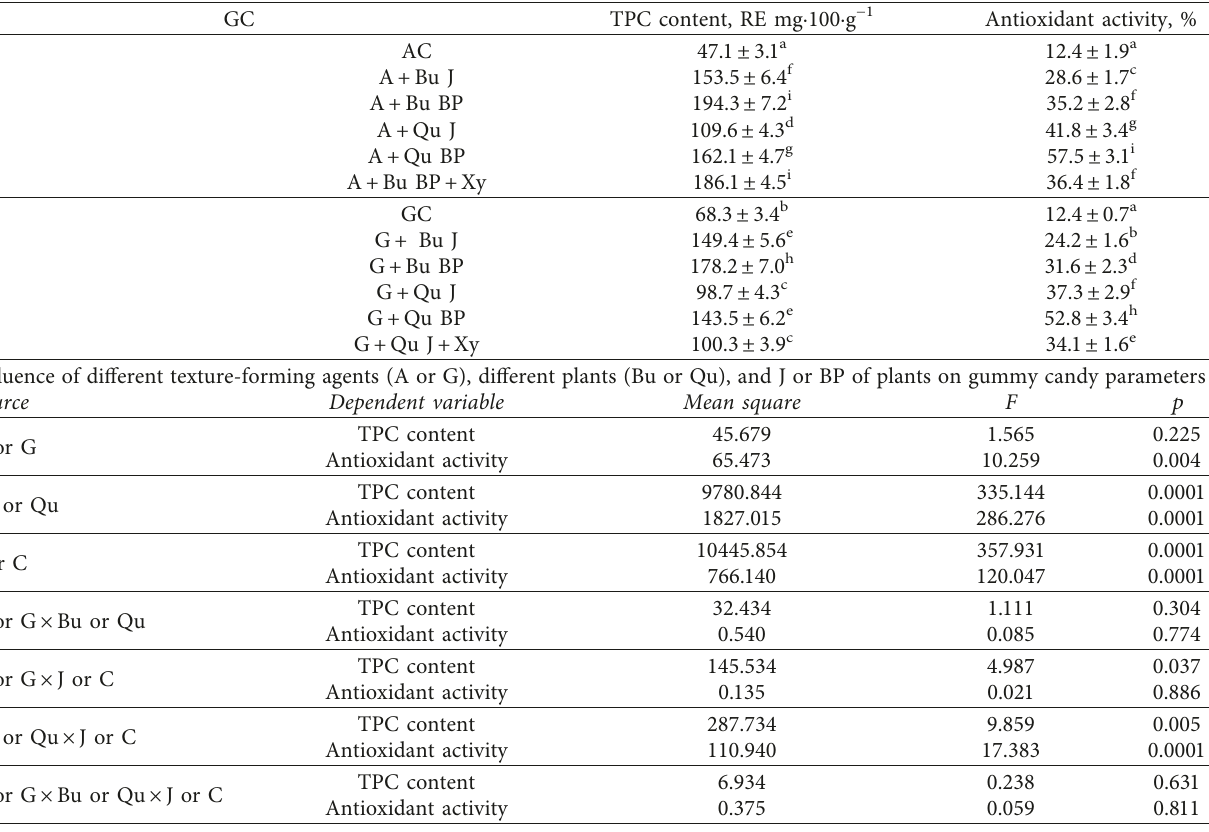
Table 4: Total phenolic compounds (TPC) content and antioxidant activity of gummy